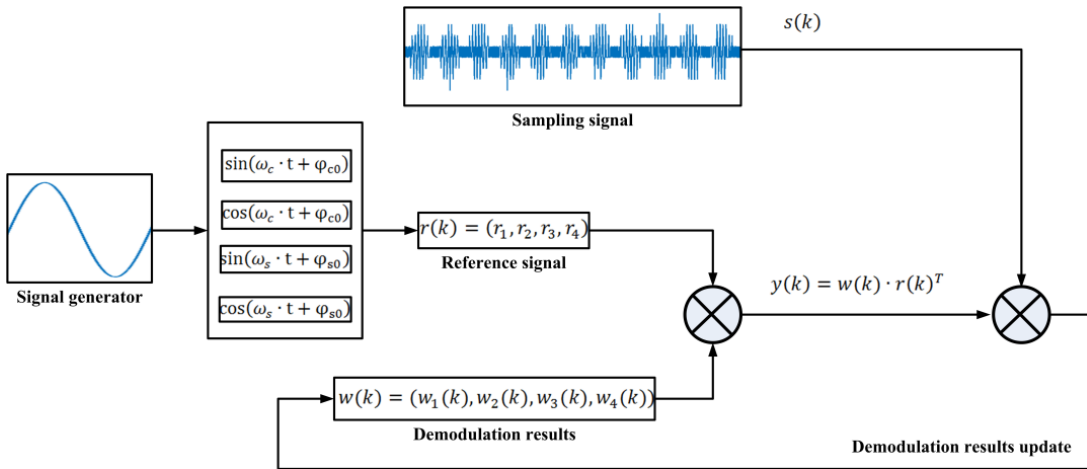
Figure 5. Block diagram of the demodulation method.